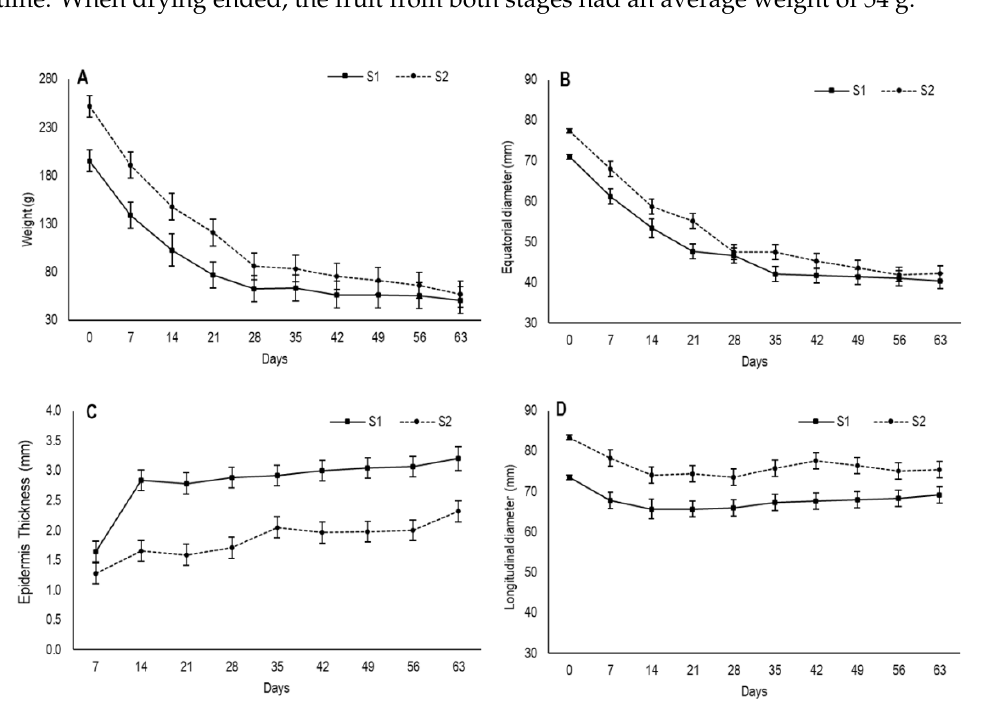
Figure 1. Changes in ( A ) weight, ( B ) equatorial diameter, ( C ) secondary epidermis thickness and ( D ) longitudinal diameter during the drying process of persimmon cv. Rojo Brillante in two maturity stages (S1 and S2). Vertical bars represent Least Significant Differences (LSD) intervals ( p ≤ 0.05).